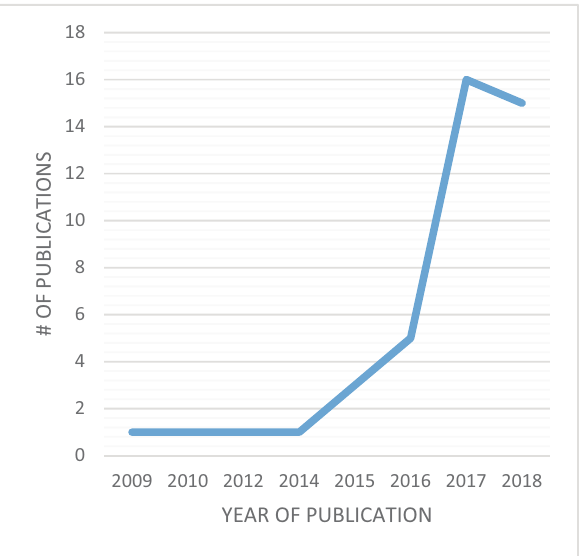
Figure 1: Number of citations with key word “ sex robots ” per year ( Scopus )